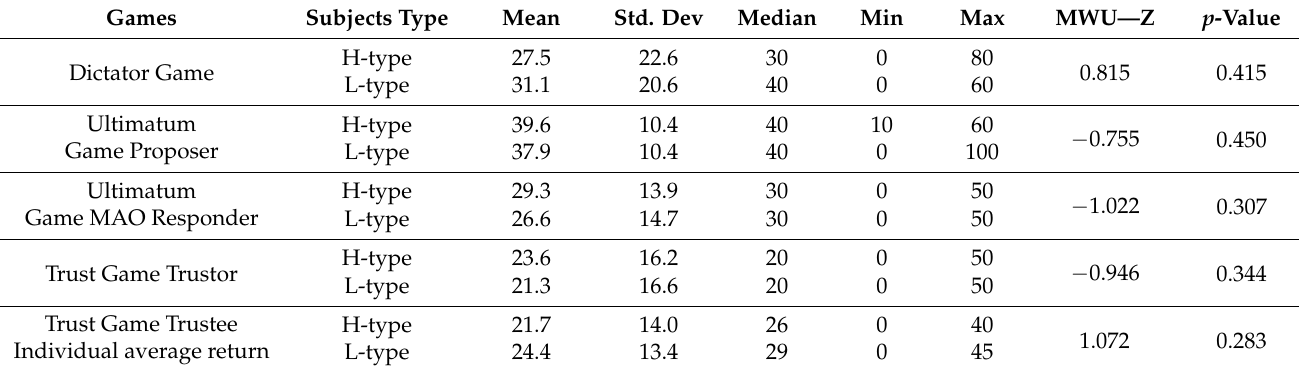
Table 3. Summary and results (Dictator Game, Ultimatum Game and Trust Game by sophistication levels—C1).